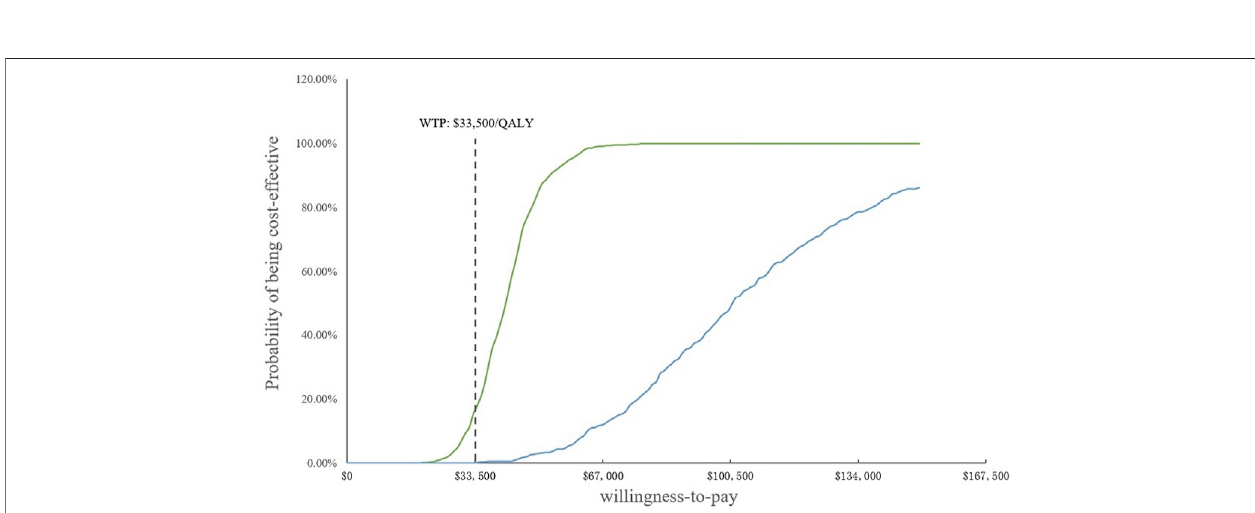
FIGURE 3 | Cost-effectiveness acceptability curves. WTP, willingness-to-pay; QALY, quality-adjusted life year.